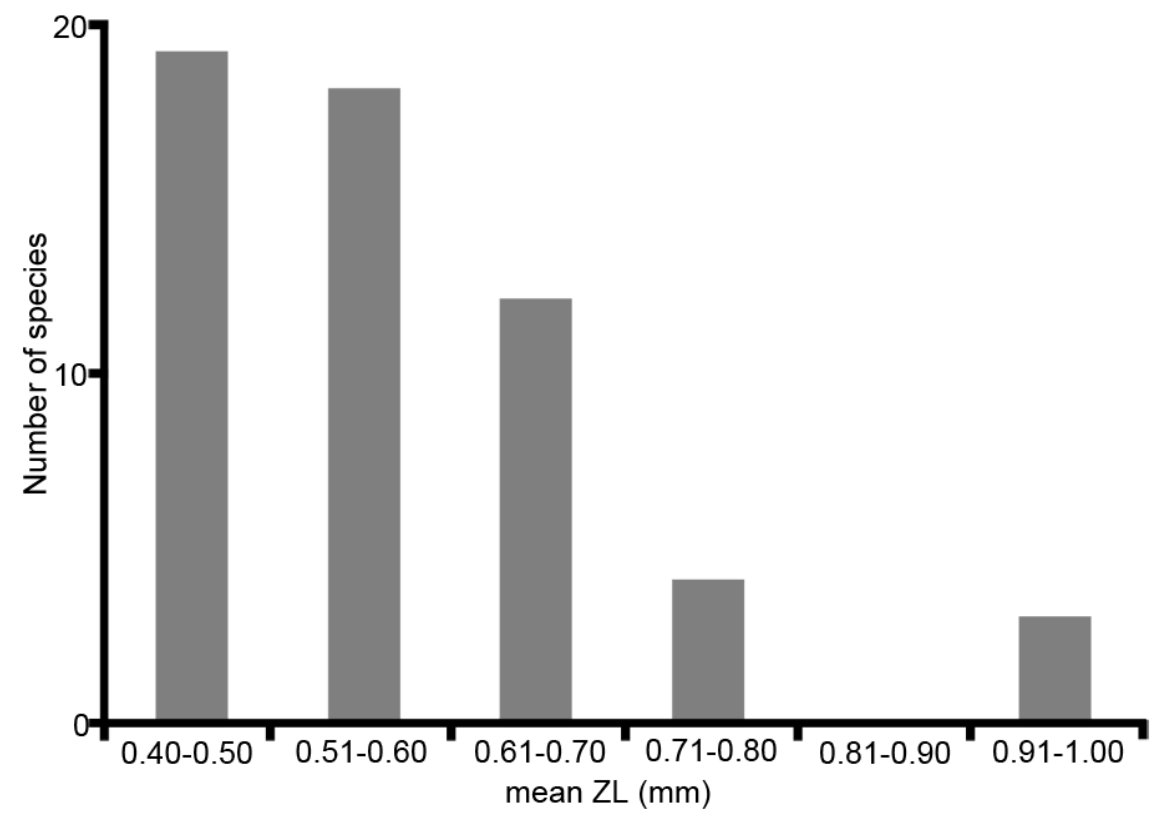
Fig. 7. Frequency distribution of zooidal size (mean ZL in mm) in 56 Microporella species known to possess ovicells and for which zooidal size has been reported in the